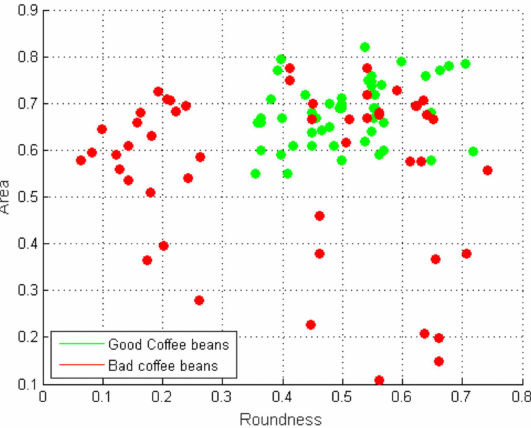
Figure 13. 2D plot of area and roundness features used for the k -nearest neighbor algorithm using the training set.